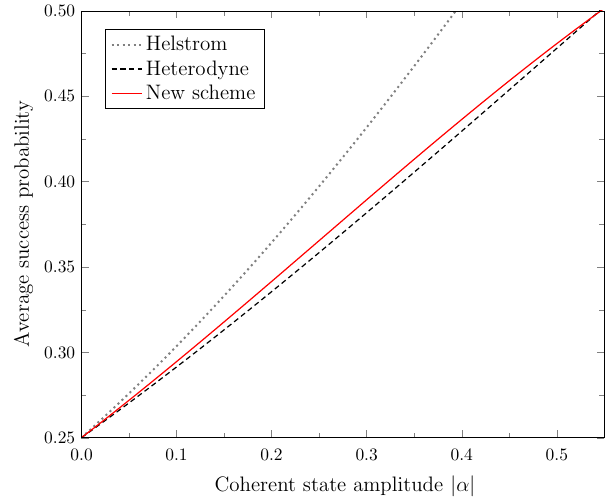
FIG. 4. Optimised average success probability of distinguish- ing QPSK coherent states as a function of the signal amplitude α is shown with a solid red line. For comparison, the success probabilities attainable with heterodyne measurements is indi- cated with a dashed black line and the Helstrom bound [22] with a dotted gray line. Note that our decoder beats the SQL for weak amplitudes.